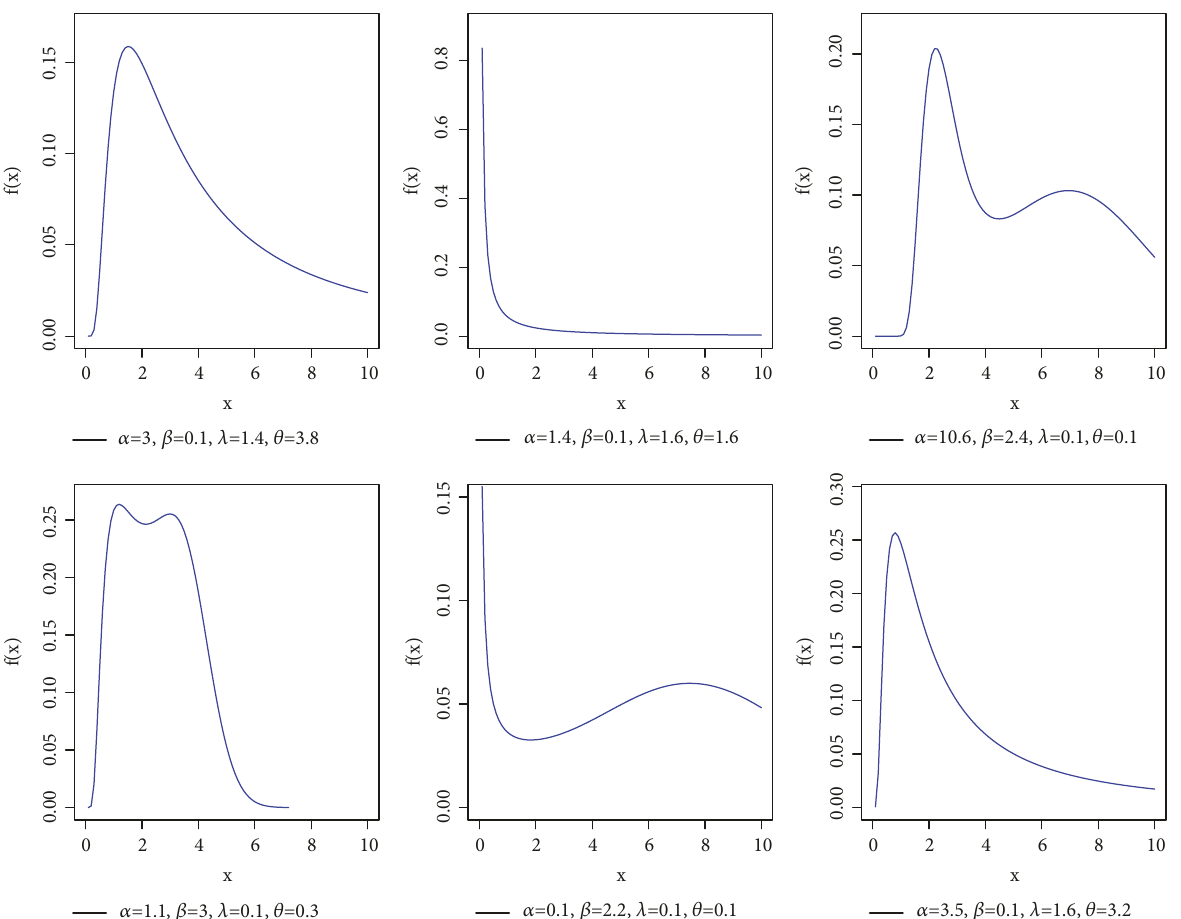
Figure 3: Plots of the EOFW distribution density